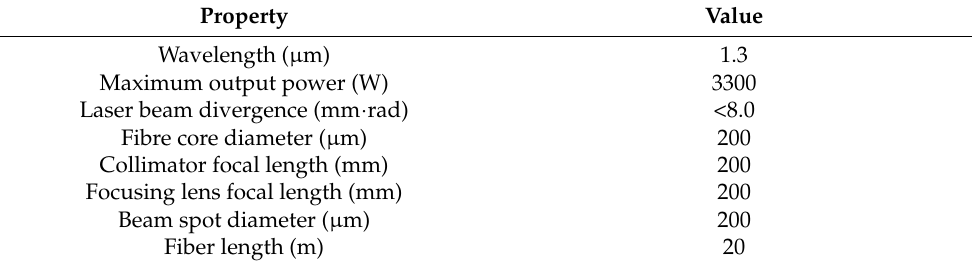
Table 2. Technical specifications of TRUMPH Trudisc 3302 laser.